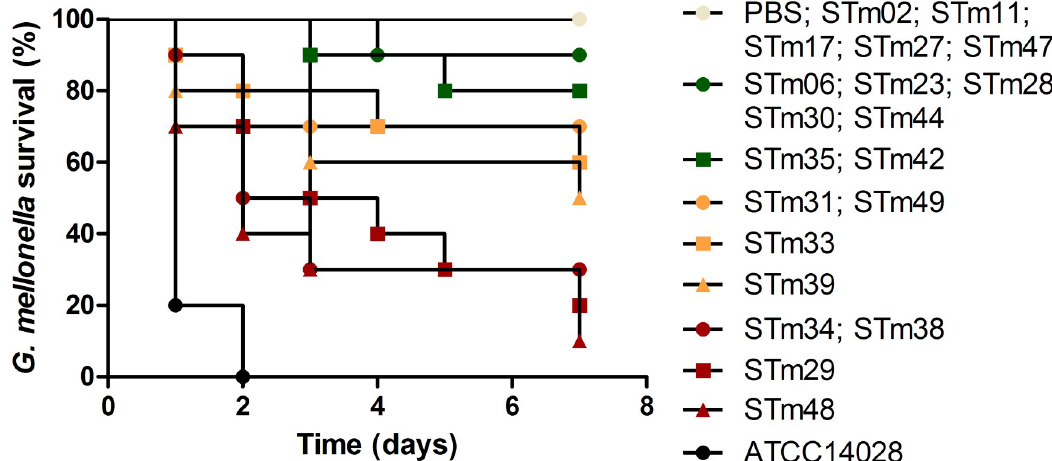
Fig 4. Survival percentages of Galleria mellonella larvae infected with 20 Salmonella Typhimurium isolates from humans in Brazil after seven days.